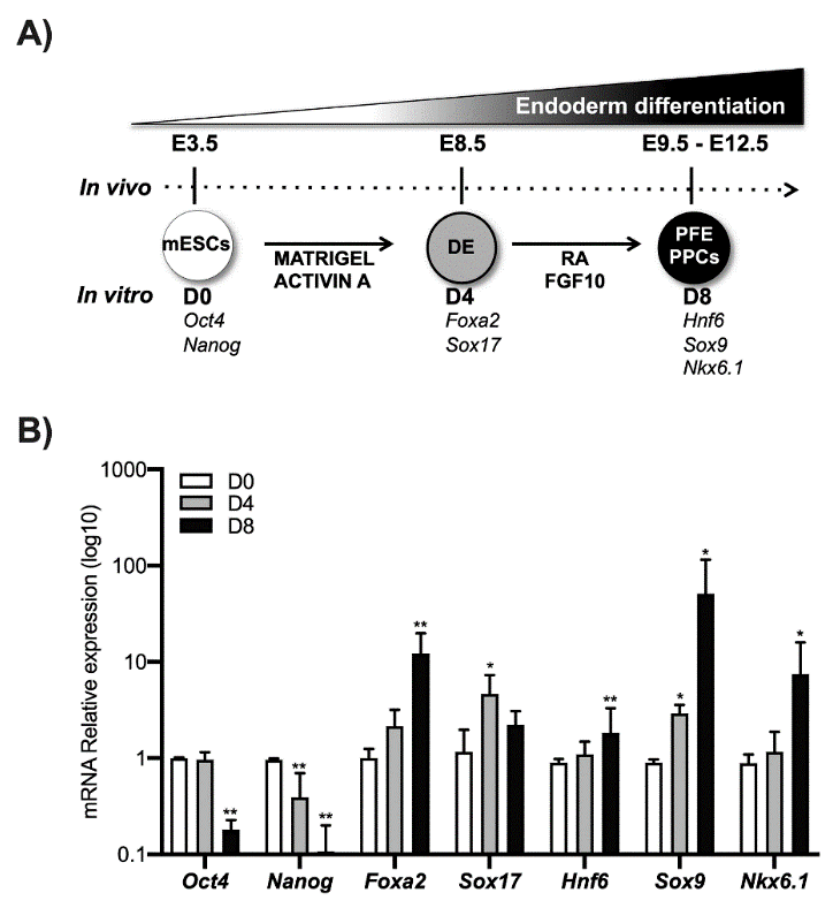
Figure 1. ESCs differentiation toward pancreatic lineage. ( A ) ESCs (D0) were cultured for 4 days treated with activin A (30 ng/mL) (D4), the definitive endoderm (DE) cells were cultured for another 4 days in the presence of both RA and FGF10 to obtain the Posterior Foregut Endoderm (PFE) and enrichment of PPCs (D8). The correspondence of the in vivo and in vitro phases was indicated. ( B ) Pluripotency markers ( Nanog and Oct4 ), definitive endoderm markers ( Foxa2 and Sox17 ), Posterior Foregut ( Hnf6 ), and Pancreatic Progenitor Cell markers ( Sox9 and Nkx6.1 ) were analyzed by qPCR. Data points represent the average of three independent experiments ± SD. * p < 0.05; ** p < 0.01.